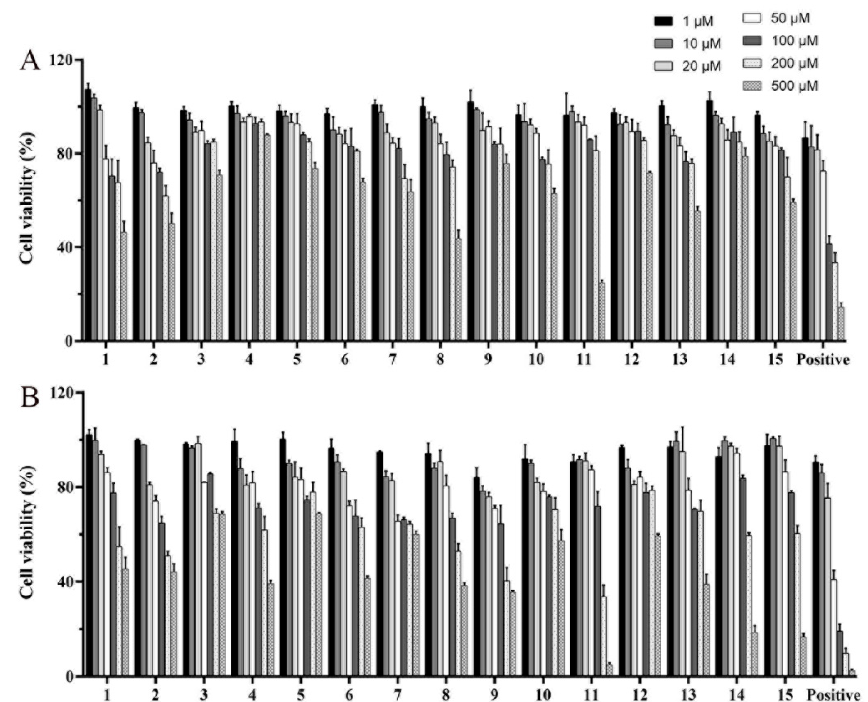
Figure 4. Cell viability of compounds 1 – 15 positive (ATC) with the concentration range of 1–500 µ M in BRL cells for 24 h ( A ) and 48 h ( B ). Table 2. The IC 50 value of compounds 1 – 15 and positive (ATC) in BRL cells.